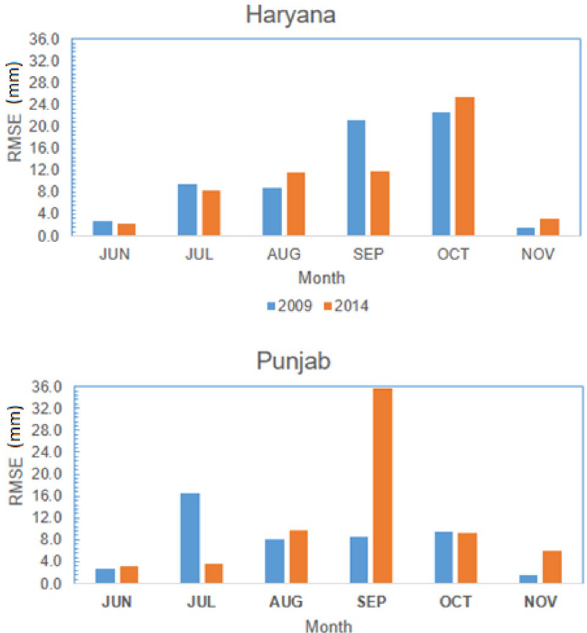
Figure 6. Regional validation of WRF monthly rainfall simulations against TRMM across Punjab and Haryana based on average RMSE values for each month from Jun to Nov during 2009 and 2014.